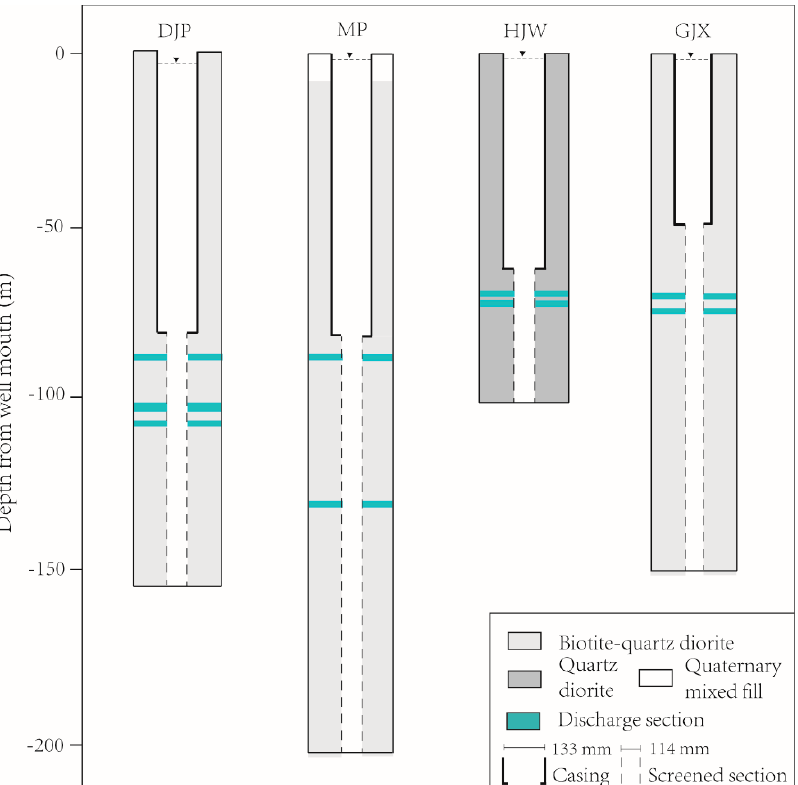
Figure 2. Structure and lithologic log of the four wells. The figure was adapted from Che [29]. There are three faults adjacent to the four wells: the Gaojiachong (GJC) fault, the Changmutuo (CMT) fault and the Taipingxi (TPX) fault. The GJC fault is an NNW-trending compressive fault and, it dips from N60 ◦ E to N85 ◦ E. Its general width is 16~23 m. Inner the fault, the mylonite is 0.3~1.05 m wide; in some places, there are 0.5 m wide breccia and 0.5~1.3 m wide phyllite with a wavy extension; there are several veins filled in the fault. The CMT fault is a 20~25 m wide extensional fault. Its trending is NNE in the north section, SN in the middle section and NNW in the south section. The fault dips from N70